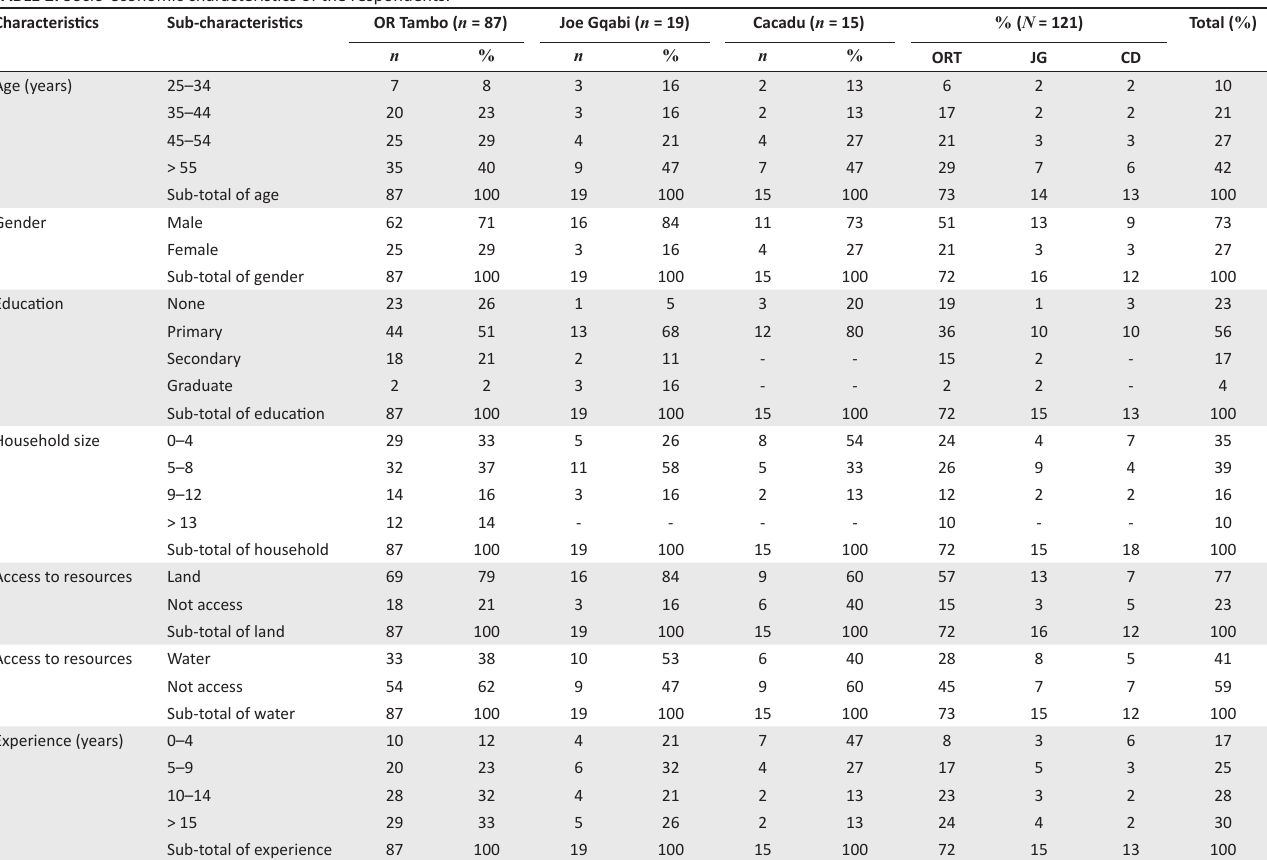
TABLE 2: Socio-economic characteristics of the respondents.